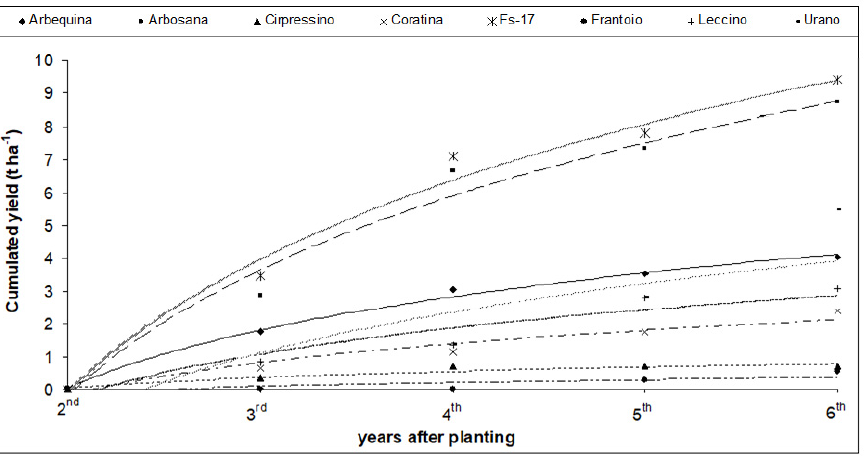
Figure 8. The von Bertalanffy functions of cumulated yield (CY, t ha − 1 ) for eightcultivars from second